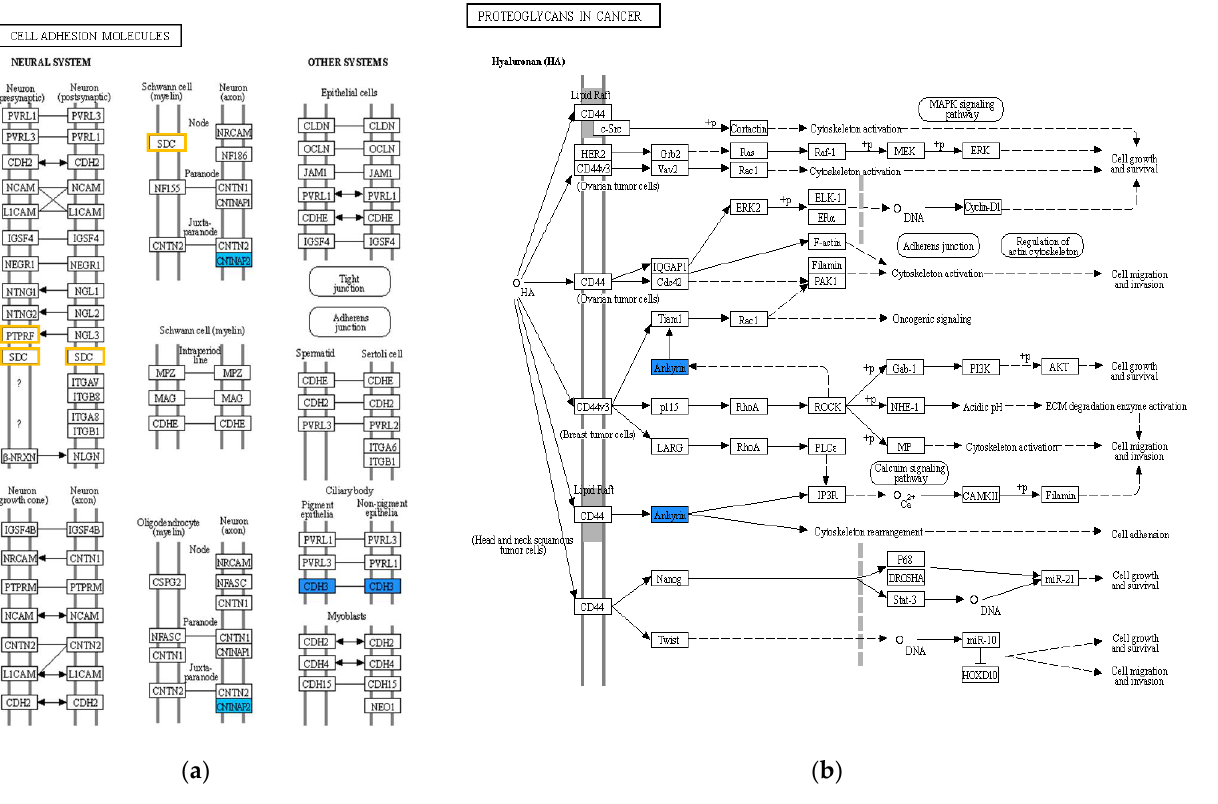
Figure 4. KEGG pathway for 16 genes. ( a ) Cell adhesion molecules and ( b ) proteoglycans in cancer pathways for the YD-8 vs. YD-8/CIS and YD-9 vs. YD-9/CIS comparisons. Genes in the color box have significantly different expression. Red indicates upregulated genes, blue indicates downregulated genes, and yellow indicates contra-regulated genes.